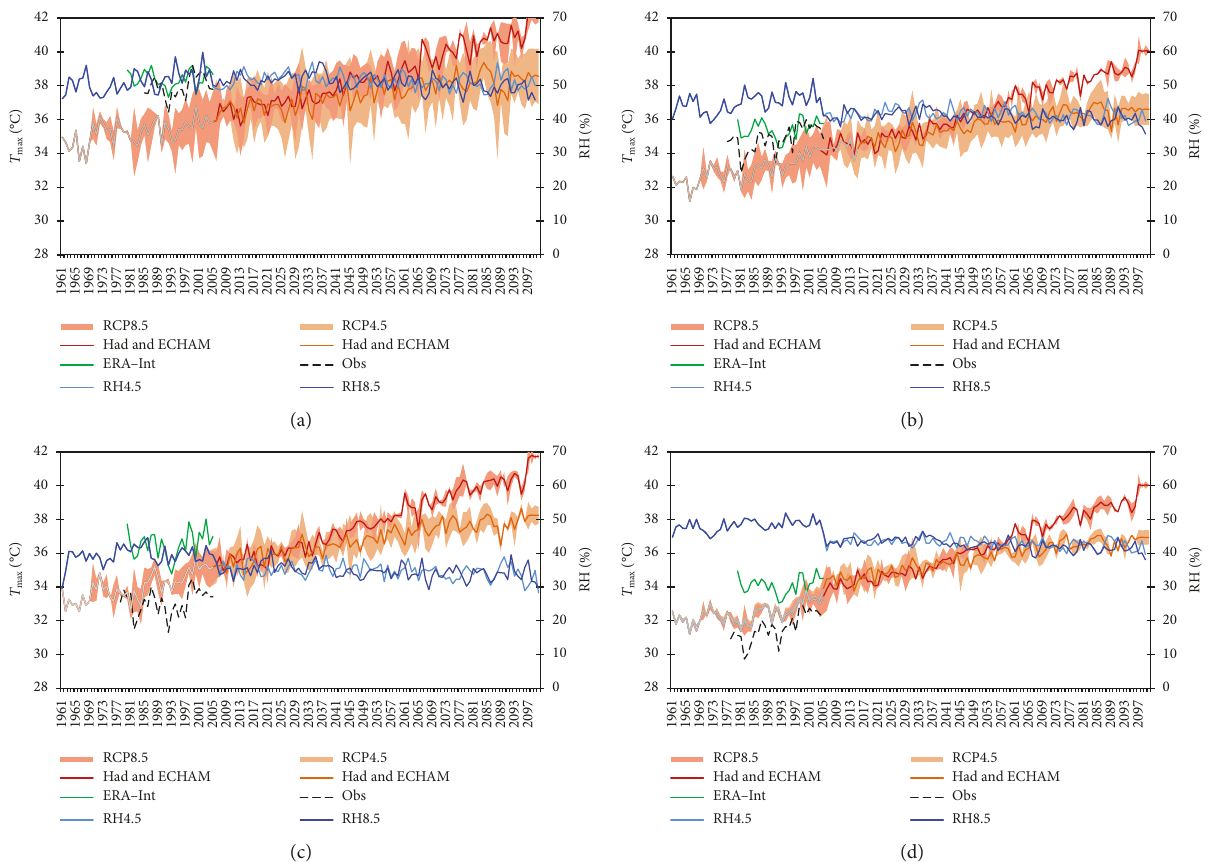
Figure 12: Simulated maximum temperature extracted nearer grid point of the station locations for (a) Makkah, (b) Madinah, (c) Riyadh, and (d) Saudi Arabia (averaged over 27 stations) for both RCP4.5 and RCP8.5 along with ERA-Int and surface observational data. For RegCM simulations, average taken from HadGEM2- and ECHAM6-driven runs are also shown by solid lines. Shaded area shows the range. The relative humidity (in %) is also shown for each panel (RH85 and RH45 for, respectively, RCP8.5 and